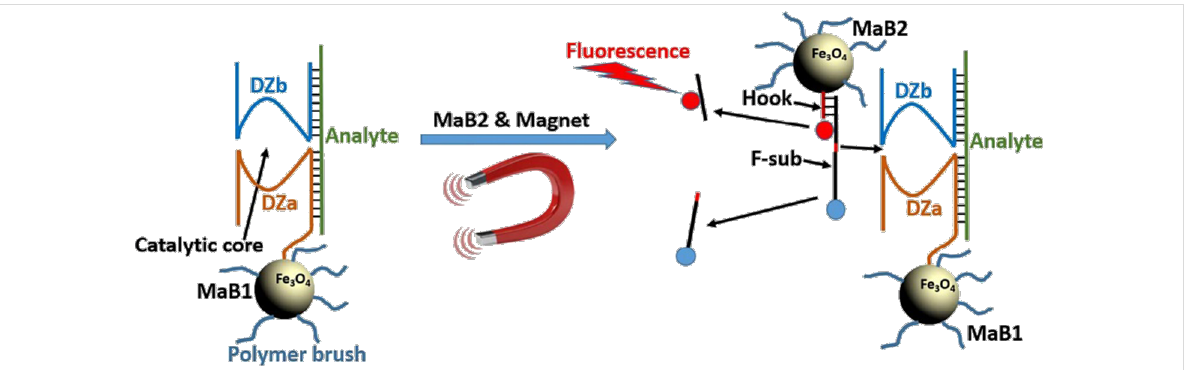
Figure 1: Working principle of MaBiDZ. Magnetic bead (MaB1)-bound DZa forms a catalytic core with DZb in the presence of analyte. The magnetic bead (MaB) architecture is composed of a 15 nm iron oxide (Fe 3 O 4 ) superparamagnetic core encased in a silica shell. The DNA strands are conju- gated to the polymeric brush using a flexible linker. The brush permits passage of the nanoparticles through cell membranes, and prevents nanoparti- cle aggregation in the absence of a magnetic field. This allows the gated compartments to form only in the presence of a magnetic field (ca. 0.4 T), creating a stimuli-responsive nanoreactor. The activated nanoreactor produces a signal only when (i) a second species of magnetic beads, MaB2 carrying F-sub, is present and (ii) a magnetic field that aggregates MaB1 and MaB2 is applied. Adapted with permission of the Royal Society of Chem- istry, from [27]; (“Nanoreactors Based on DNAzyme-Functionalized Magnetic Nanoparticles Activated by Magnetic Field” by S. F. Bakshi et al., Nano- scale, vol. 10, issue 3, Copyright © 2018); permission conveyed through Copyright Clearance Center, Inc. This content is not subject to CC BY